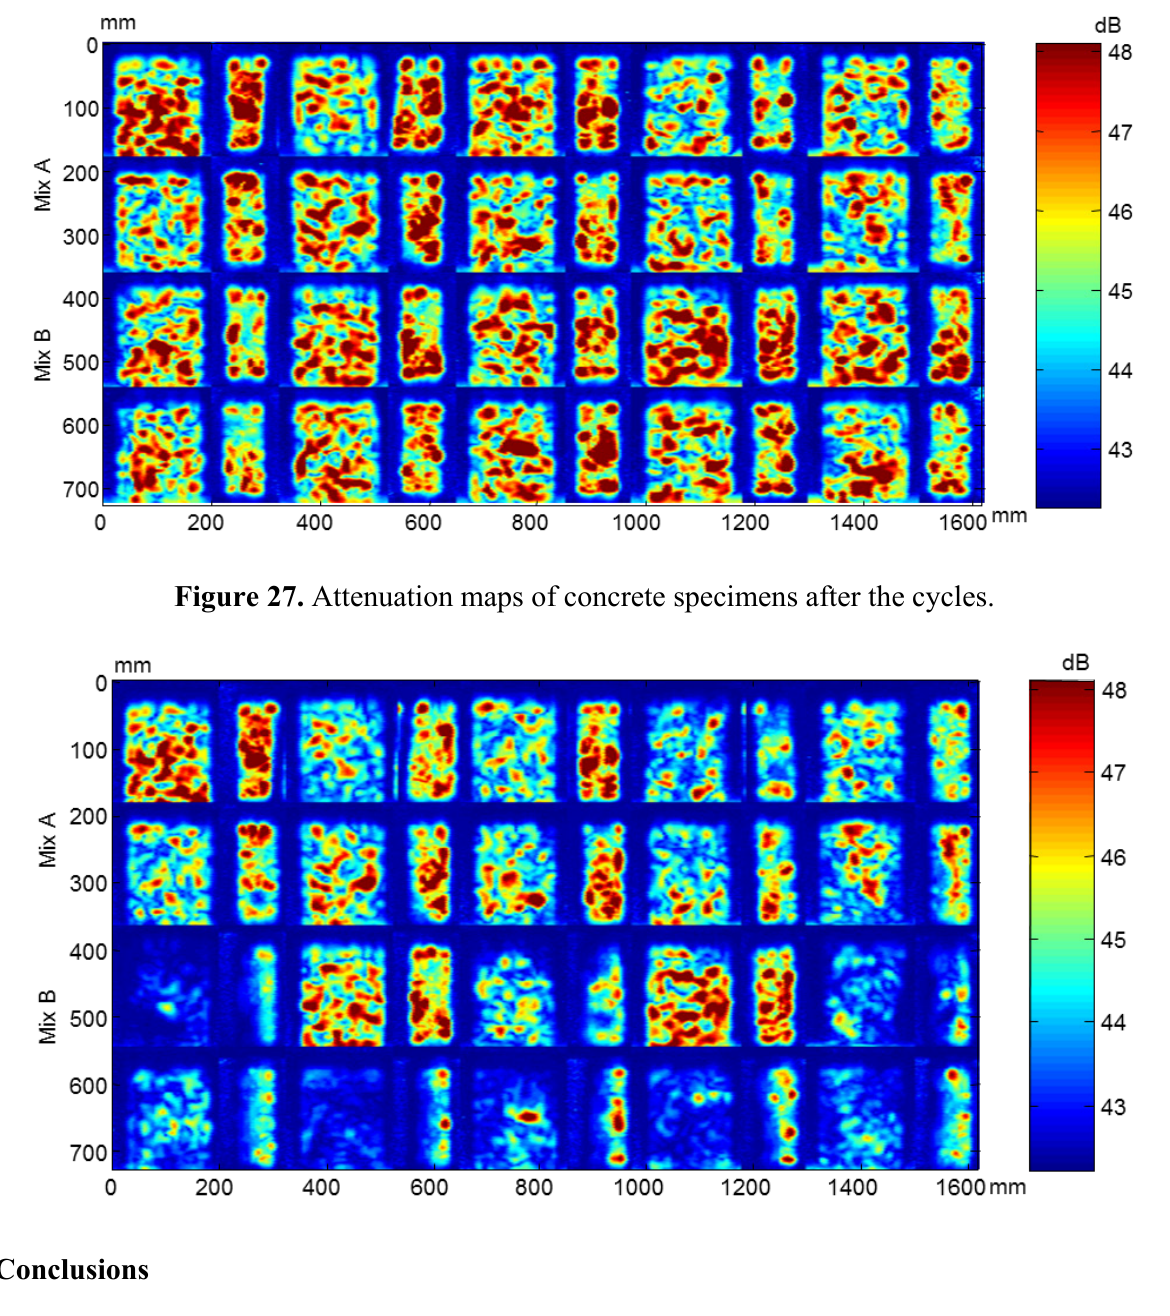
Figure 26. Attenuation maps of concrete specimens before the cycles.